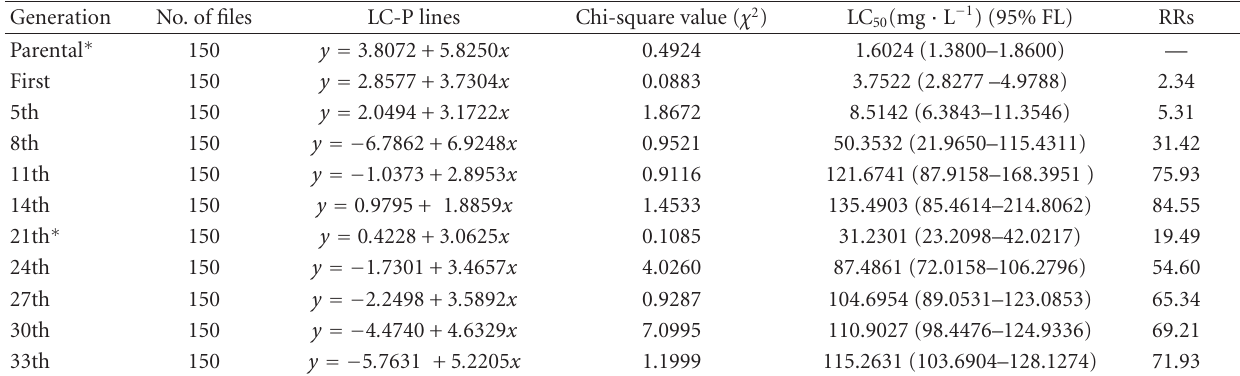
Table 1: Resistance ratios of the Trichlorphon-resistant line at selected